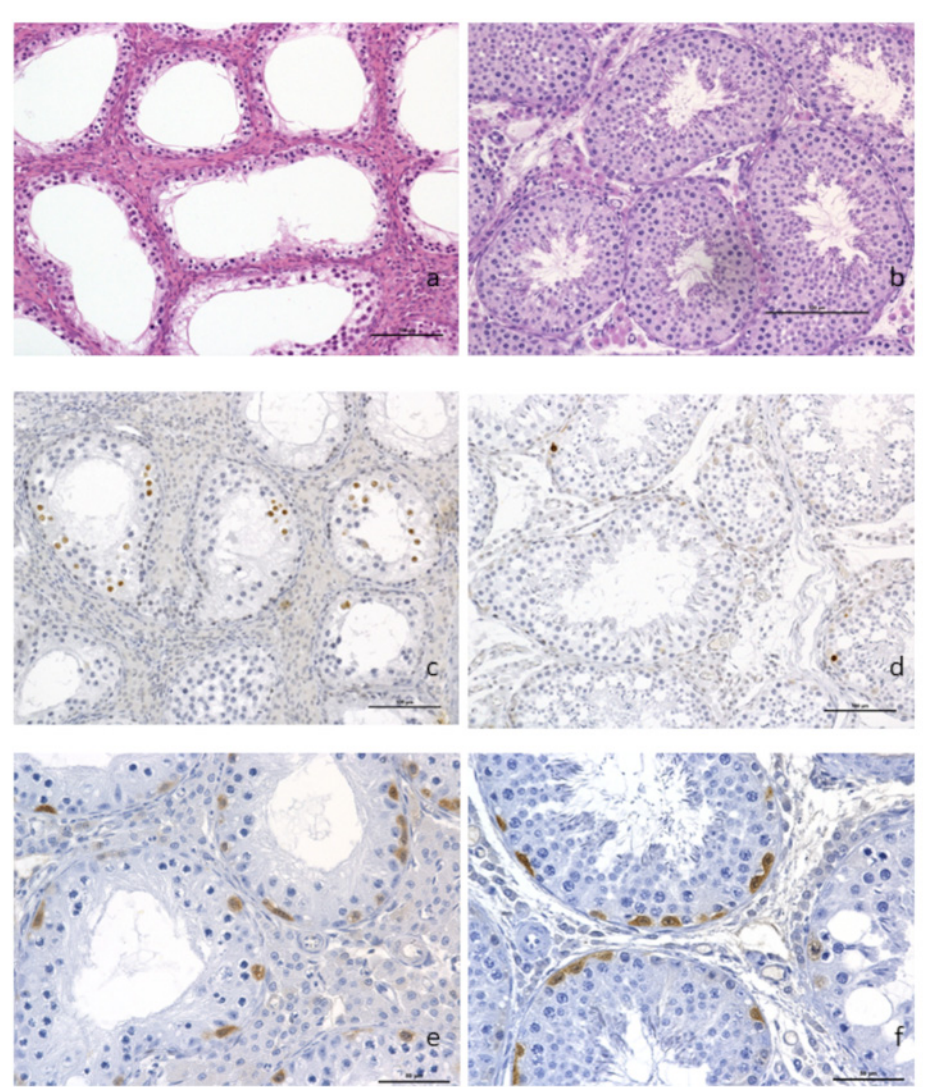
Figure 2. Histopathological analysis of testicular tissue. ( a ) Complete arrest of spermatogenesis with hyperplasia of the Leydig interstitial cells ( × 200) and presence of spermatogonia and primary spermatocytes but no evidence of further cell maturation. ( b ) control boar with normal spermato- genesis. Anti-caspase-3 immunohistochemistry on paraffin sections from t(1;15) ( c ) and control ( d ) testis samples ( × 200). A higher proportion of positive spermatocytes (dark brown staining of the nuclei) was observed in the testis of the translocated boar as compared to the control. Labeling of undifferentiated spermatogonia using PGP9.5 antibodies, translocated boar and ( e ) control ( f ) ( × 400). Scale bars are equal to 100 µ m ( a – d ) and 50 µ m ( e , f